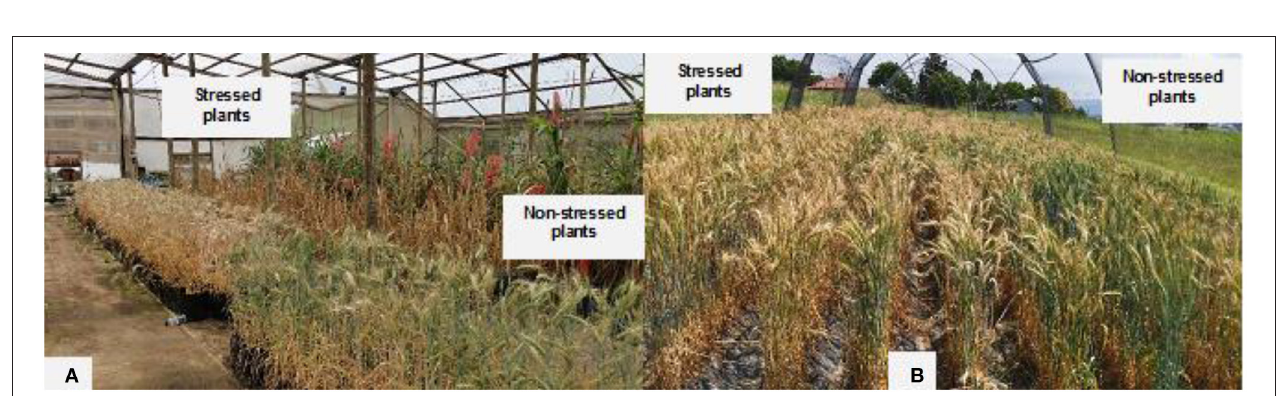
FIGURE 5 | Differences between drought-stressed and non-stressed M 4 wheat populations at (A) the controlled environment facility and (B) Ukulinga research farm of University of KwaZulu-Natal.